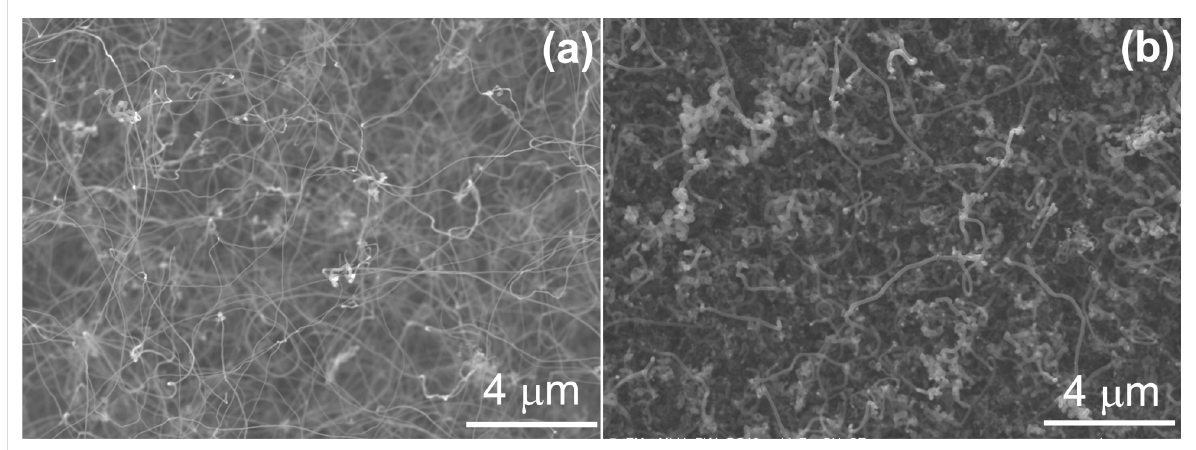
Figure 3: SEM images of CNTs deposited onto GC by CVD at 750 °C using cyclohexane and a gas flow rate of 1.7 L h − 1 for 120 min with an H 2 /Ar ratio of 1.8 (1.1 L h − 1 /0.6 L h − 1 ). (b) CNTs grown under the same conditions but with an increased total gas flow rate of 3.9 L h − 1